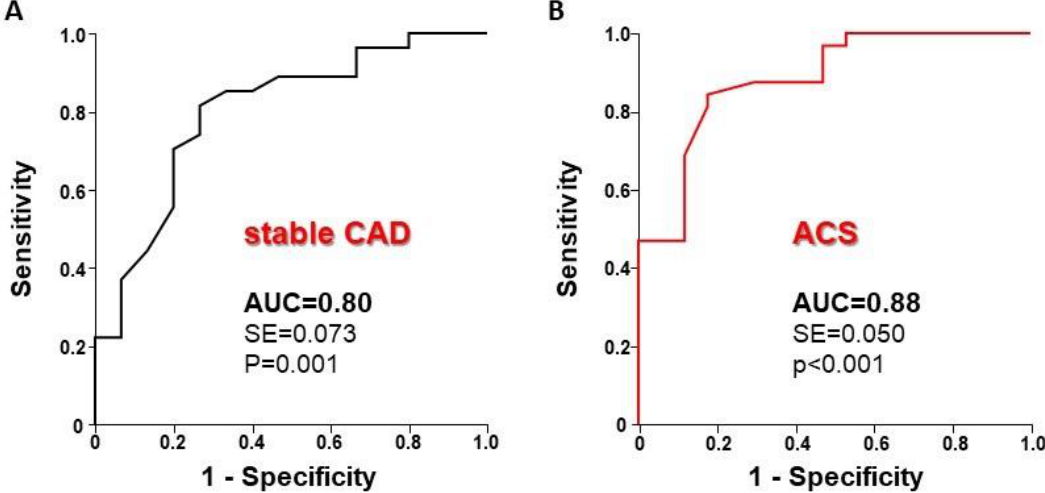
Figure 3. Diagnostic performance of the iFR. ( Panel A ) ROC curve analysis demonstrates an excellent performance of the iFR to detect FFR-positive stenoses. ( Panel B ) V-plot depicting the classification agreement between the iFR and the FFR across the percentiles of FFR values measured in the study. At univariable analysis, the left ventricular ejection fraction (LVEF) was inversely correlated with the degree of numerical discrepancy between the iFR and the FFR measurements (r = − 0.257; p = 0.017): Larger iFR – FFR differences were found for lower LVEF values (Figure 4A). At multivariable